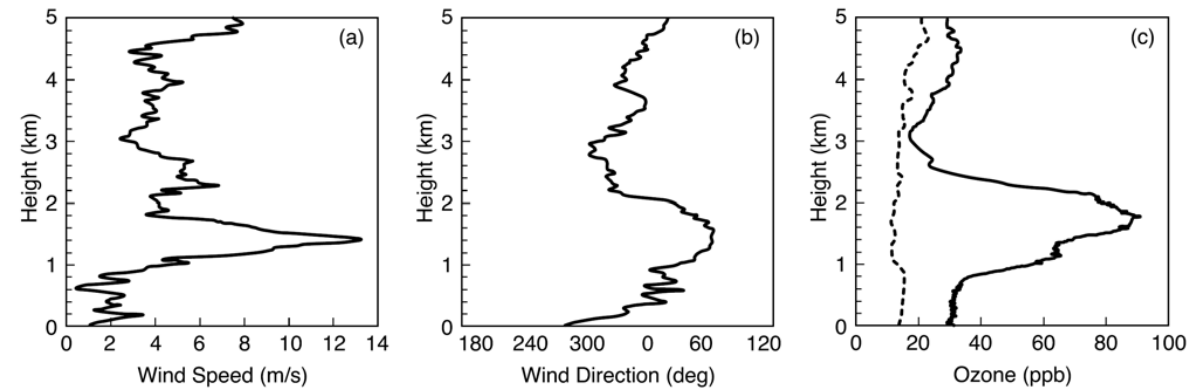
Fig. 18. Vertical profiles of (a) wind, (b) wind direction, and (c) ozone, showing an example of an elevated ozone-rich layer; based on balloon sonde measurements at the Kaashidhoo Climate Observatory (KCO) on 9 March 1999 (solid lines) and 5 February 1999 (dashed line) (redrawn from Simpson and Raman, 2004, copyright 2004 by the Springer Verlag, reproduced with